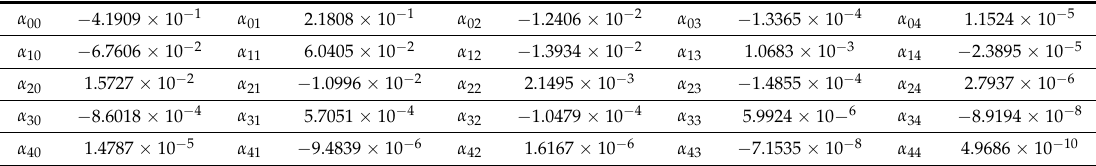
Table A1. C p coefficients α